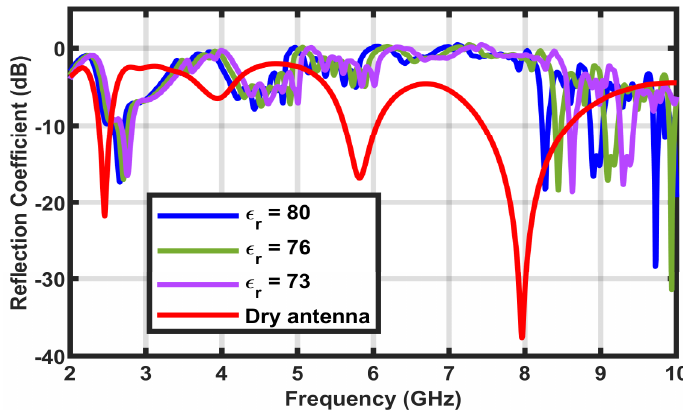
Figure 21. Reflection coefficient of the antenna under wet conditions.